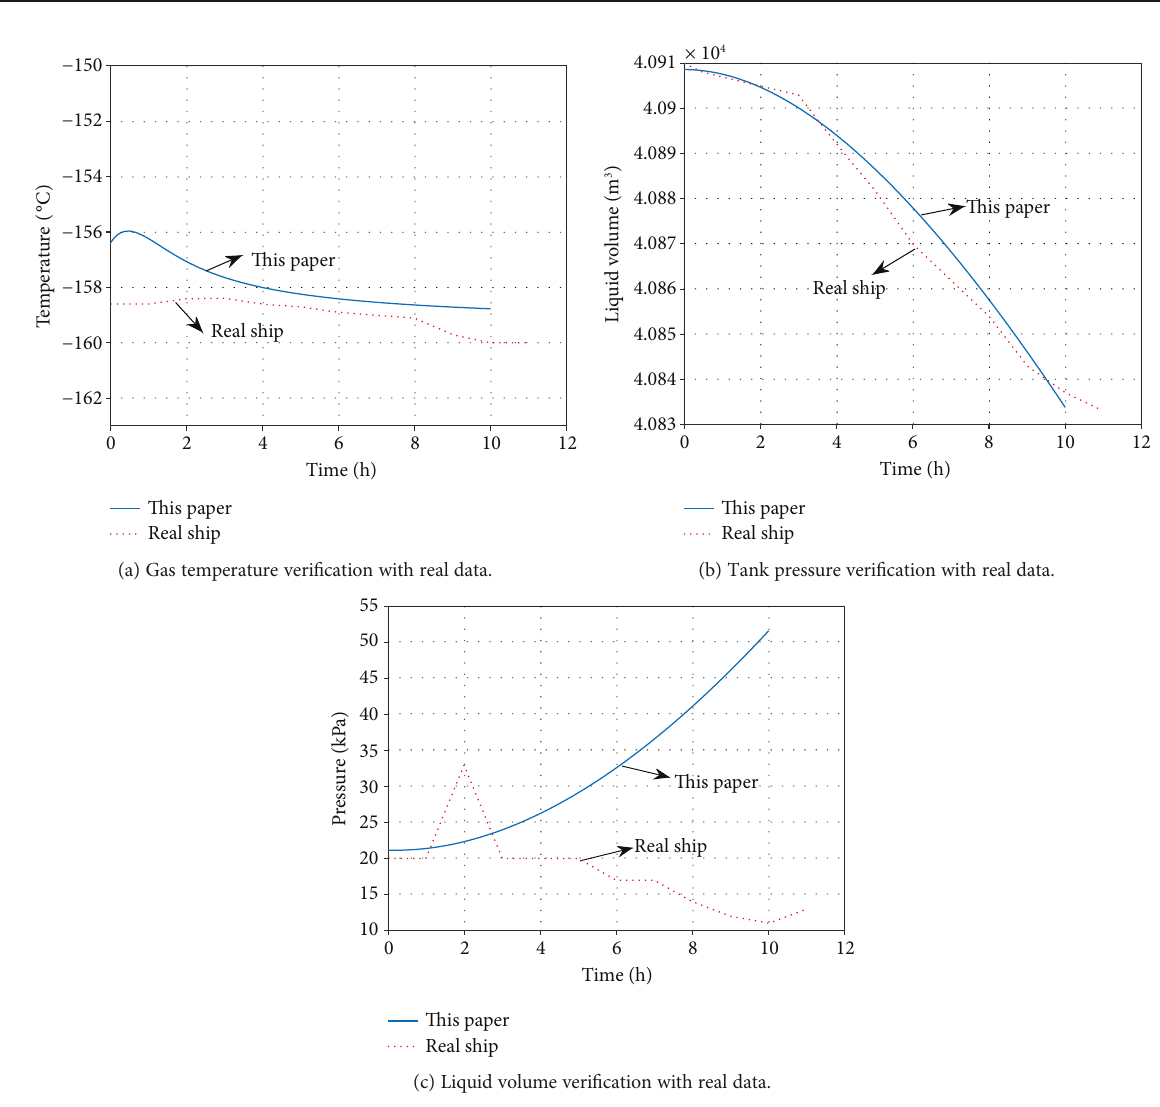
Figure 2: The comparison with real ship.